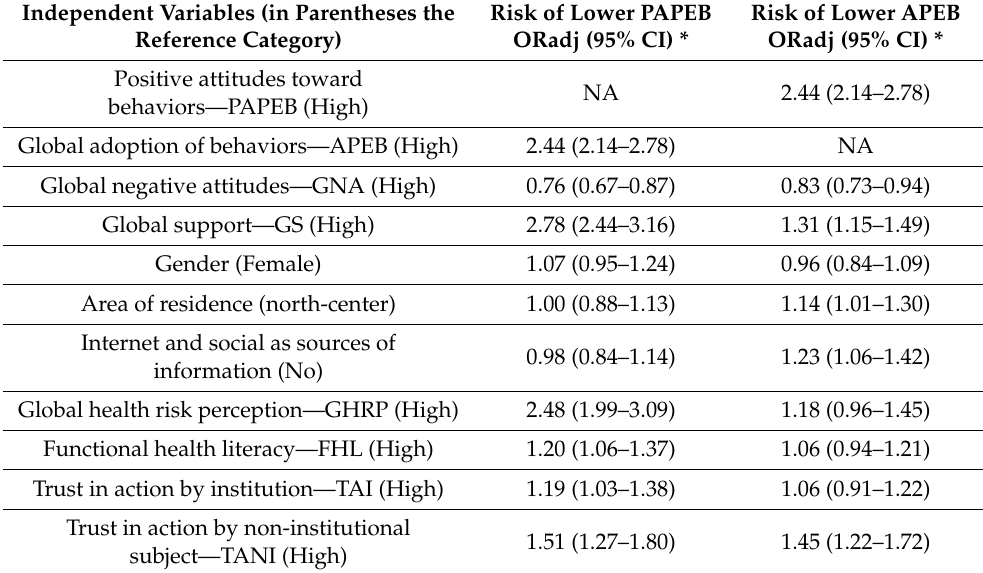
Table 4. Results of the logistic regression analyses expressed as adjusted odds ratio (ORadj) with 95% confidence interval (95%CI) for low PAPEB (<26) and low APEB (<15) according to independent variables. The ORs represent the risk of lower PAPEB (or lower APEB) in comparison with the reference categories (indicated by asterisks) of independent